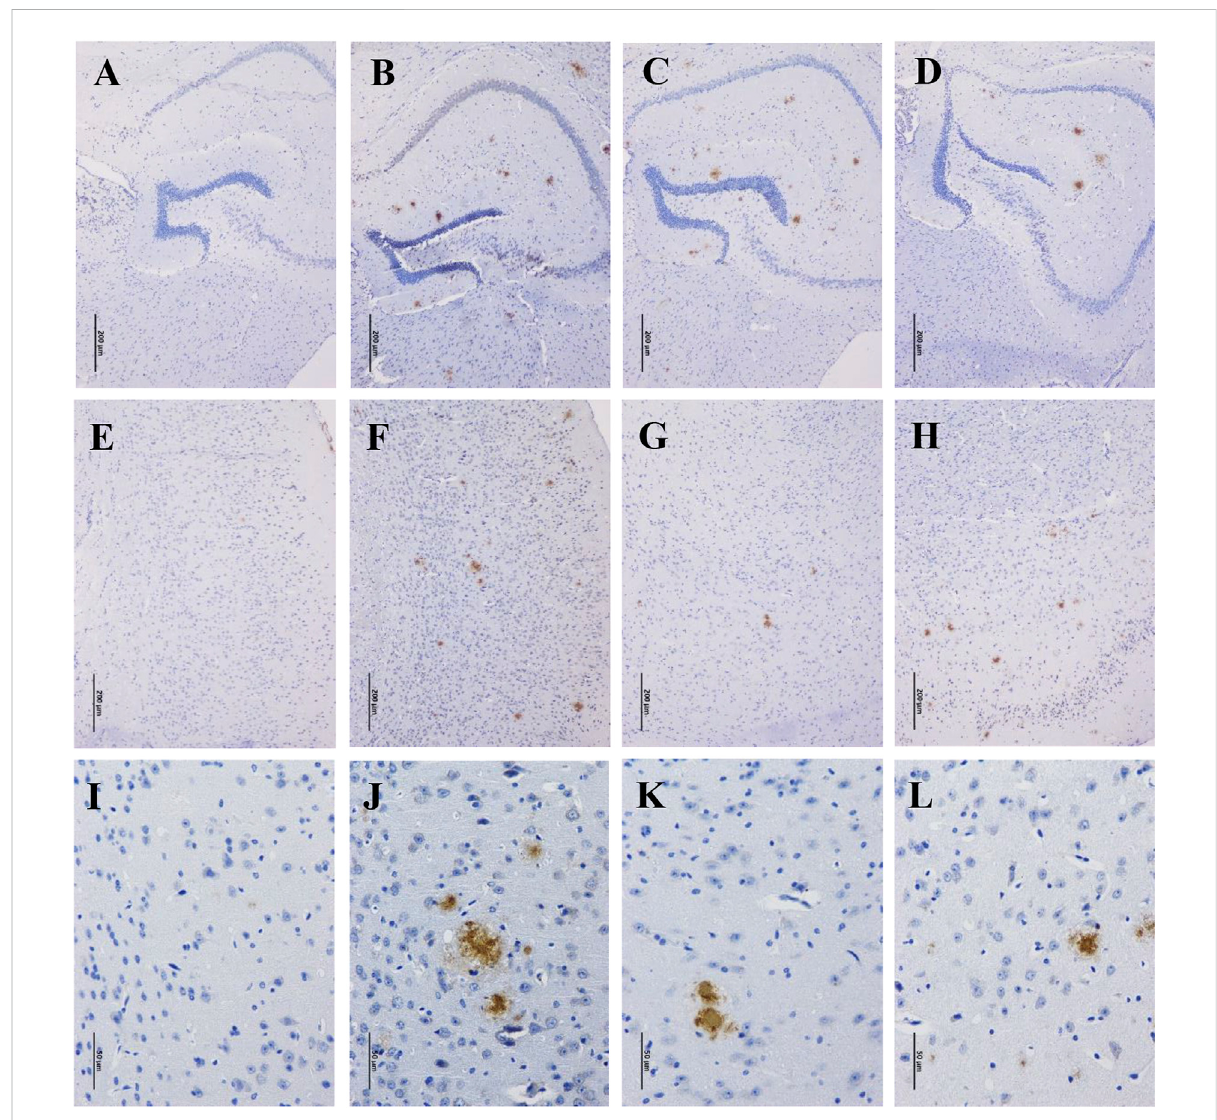
EffectsofGBLEontheexpressionof β -amyloidinhippocampusandcortexbyimmunohistochemistry. (A – D) Immunohistochemicalstainingof β -amyloid plaques in hippocampus (100×) of WT, APP/PS1, APP/PS1+ Donepezil, and APP/PS1+GBLE groups, respectively. (E – H) Immunohistochemical staining of β -amyloid plaques in cortex (100×) for each group. (I – L) Immunohistochemical staining of β -amyloid plaques in cortex (400×) for each